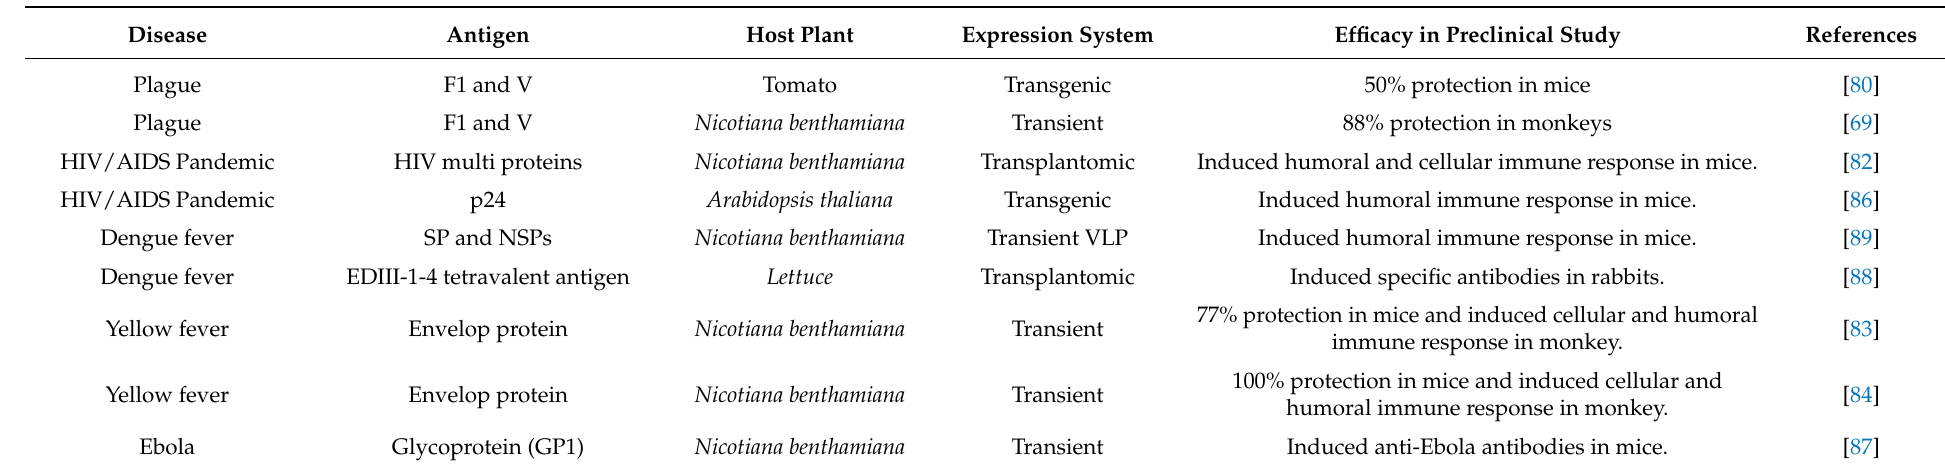
Table 3. Plant-based vaccines for epidemics in preclinical